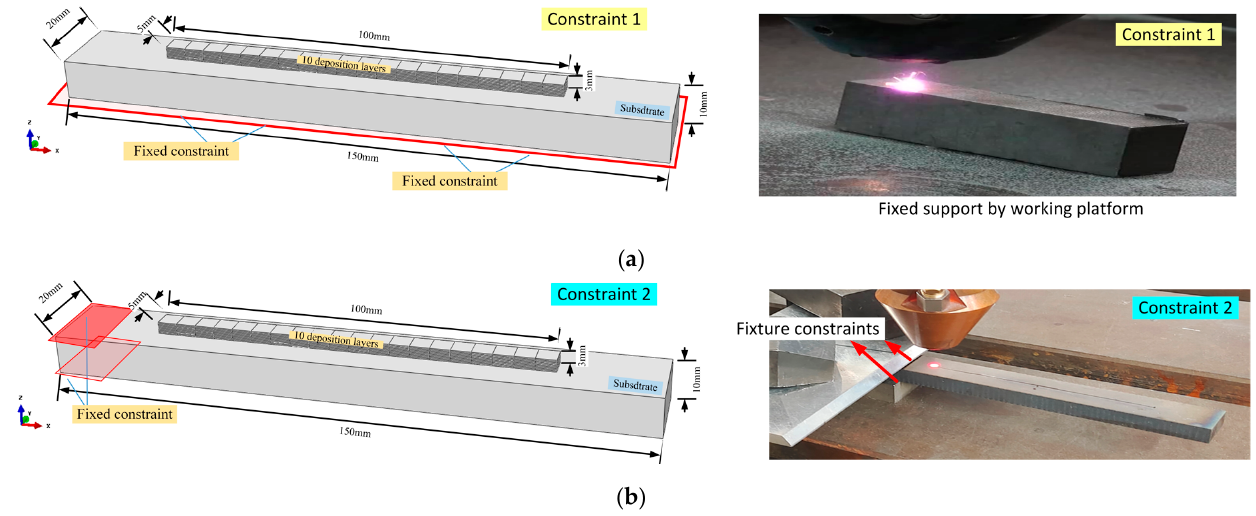
Figure 4. Different constraints on the substrate used in DED AM: ( a ) constraints on bottom surface; ( b ) constraints on the one end.